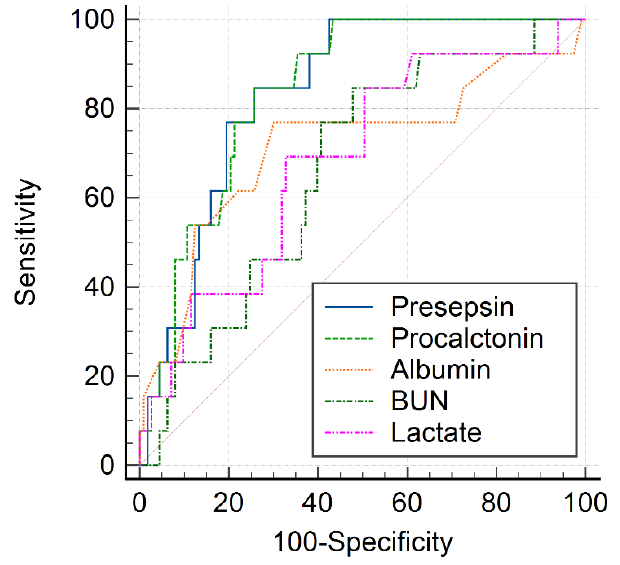
Figure 2. Receiver operating characteristic curves of laboratory biomarkers for 30-day hospital mortality in patients with COVID-19.